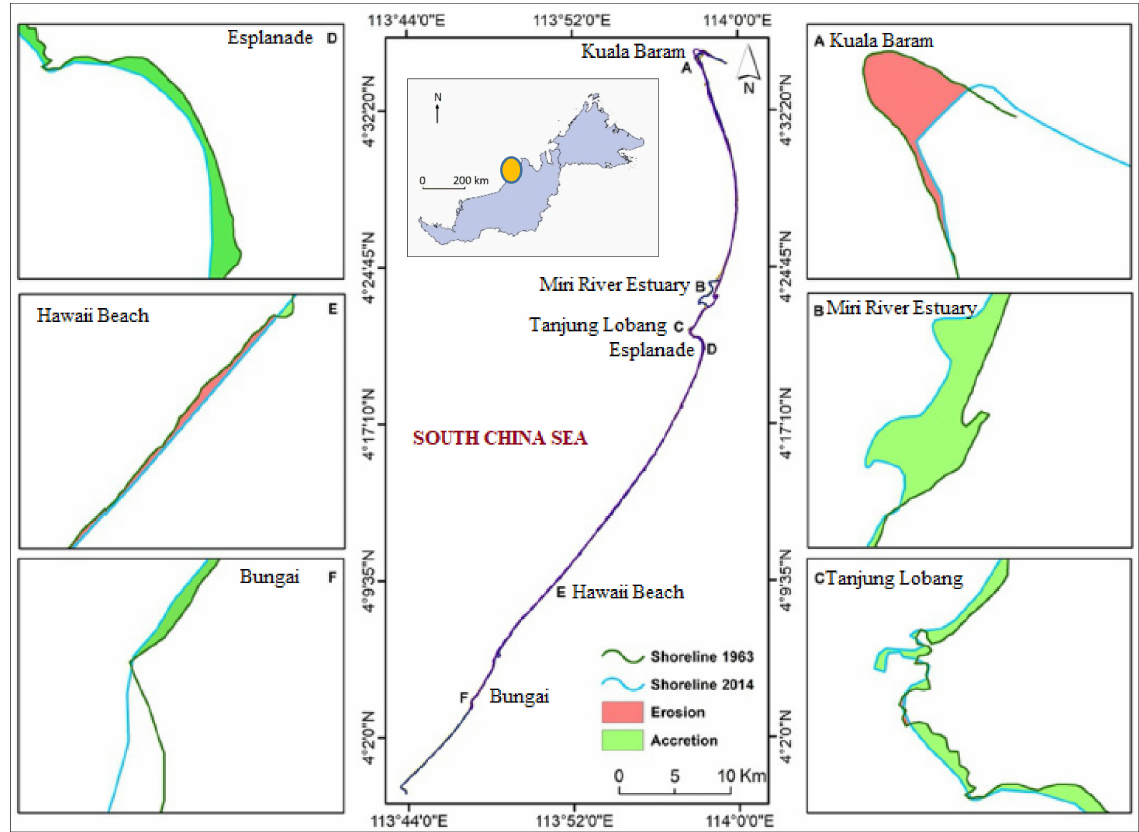
Figure 10. Shoreline changes between 1963 and 2014 in Miri, Sarawak ( A . Baram River Estuary, B . Miri River Estuary, C . Tanjong Lobang Beach, D . Esplanade beach, E . Hawaii beach and F . Bungai Beach) [87]. ‘Reprinted with permission from [87], 2019; Elsevier. License Number 5071150332416, Date 17 May